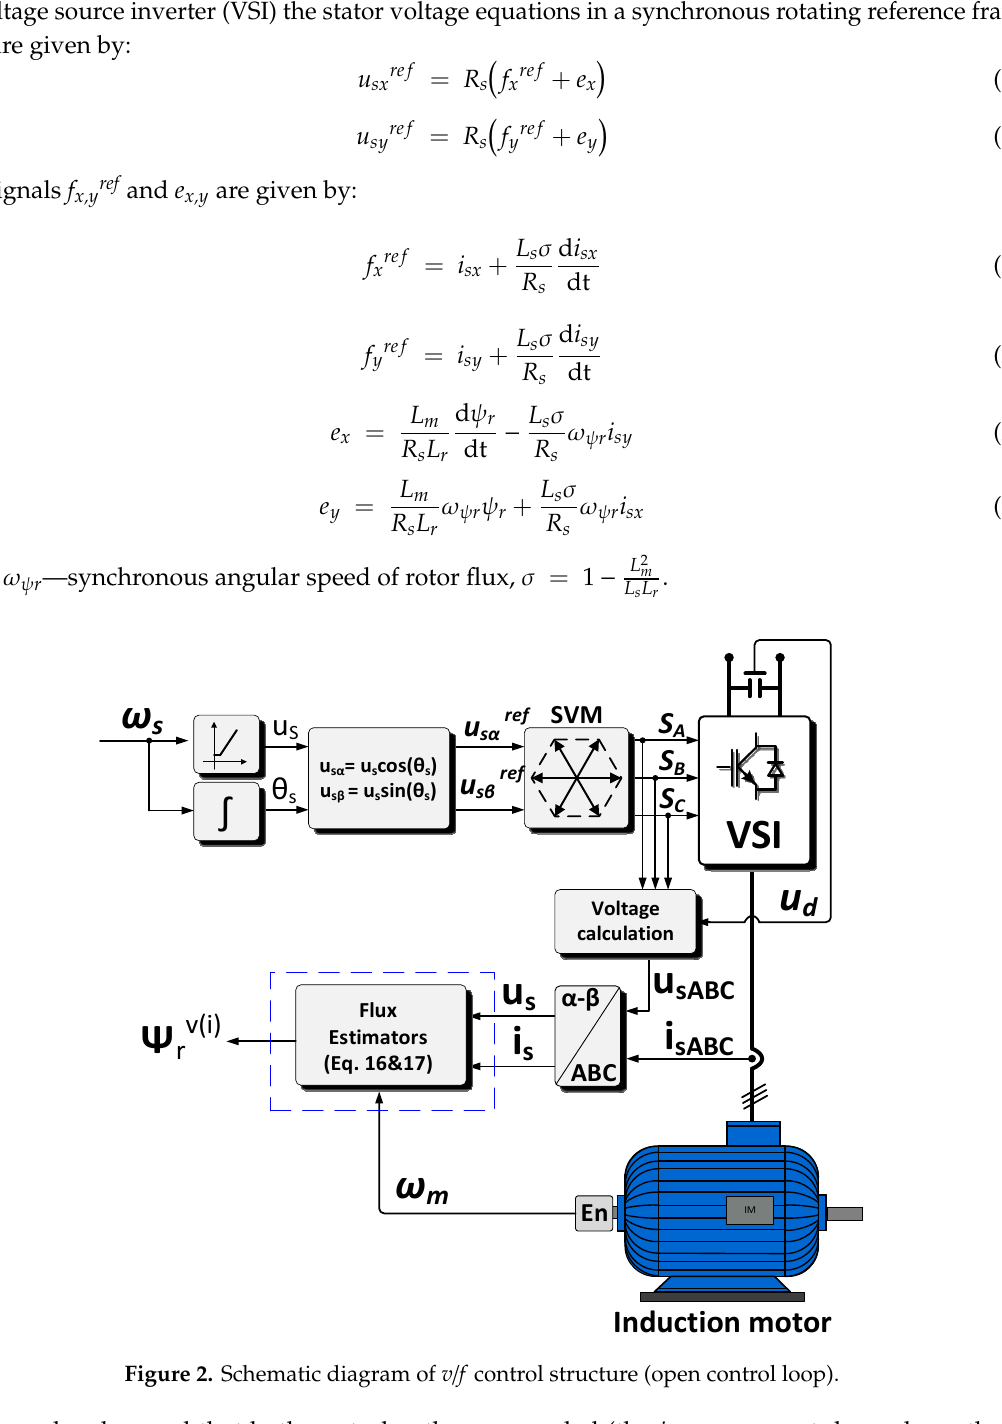
Figure 3. Direct field-oriented control structure. 5. Impact of Inter-Turn Short Circuits (ITSCs) on Rotor Flux Estimation Accuracy and Drive Performance At first, computer simulations were conducted using MATLAB/Simulink software (2016a, MathWorks, Natick, MA, USA), during which two cases were studied: operation of the drive during ITSCs in open- (in scalar control) and closed-loop control structures (DFOC). During the tests, the ITSC was simulated only in phase A, and the fraction of shorted turns was changed in accordance with the trajectory in Figure 4. The faulted condition was started at time t = 4 s, and the value of the fault fraction was increased linearly up to about 12%. This is quite a high severity of fault, but the main goal of the FTC system is the incipient detection of the ITSC, as well as compensation for its negative impact on the drive performance. Constant values of reference angular